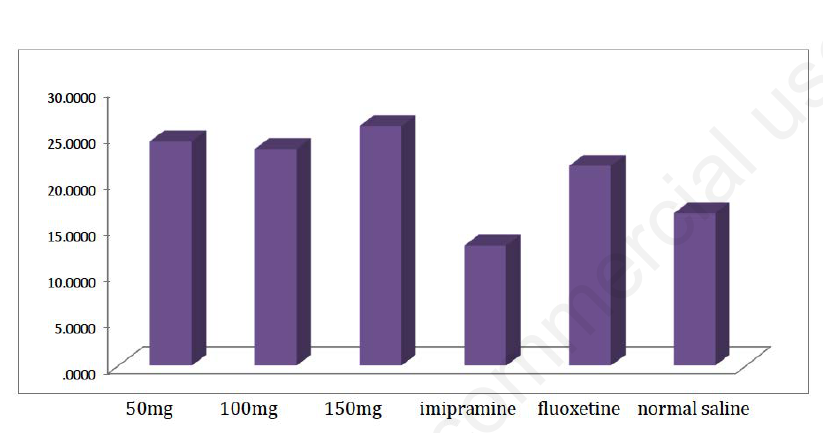
Figure 2. Effect of aqueous extract of plant (50, 100, 150 mg/kg) Lavandulifolia Stachys , imipramine, fluoxetine, normal saline on swimming. Data represents the mean activity counts per 5 min. Comparisons were made using one-way ANOVA. P<0.01.